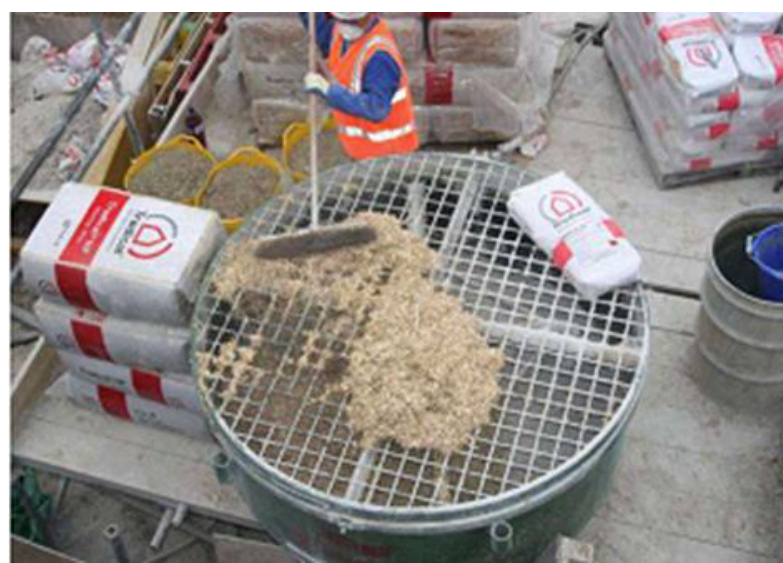
Figure 4. Process of mixing Hemp shiv with Lime